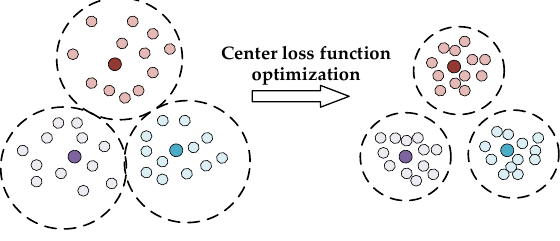
Figure 5. The cohesion of the objective function.